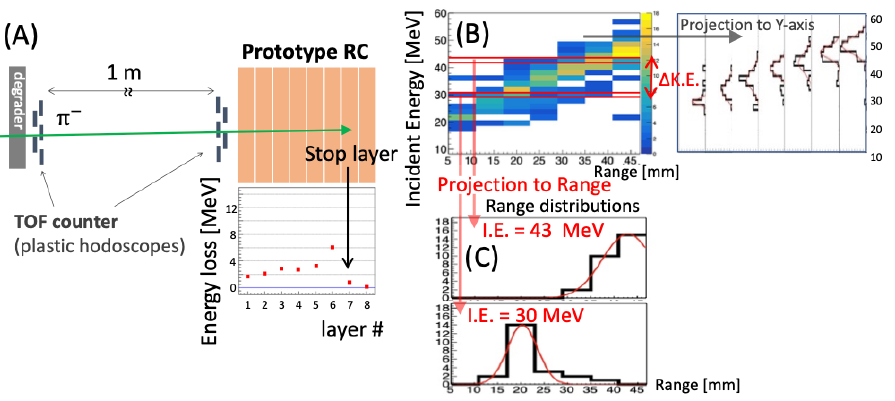
Figure 4. (A) Setup of the test experiment of a prototype range counter. The lower histogram shows the energy loss in each layer for a typical event in which a pion stopped in the prototype. (B) Correlation between incident energy and range for stop pion events. (C) Two distributions of range at energy regions around 43 and